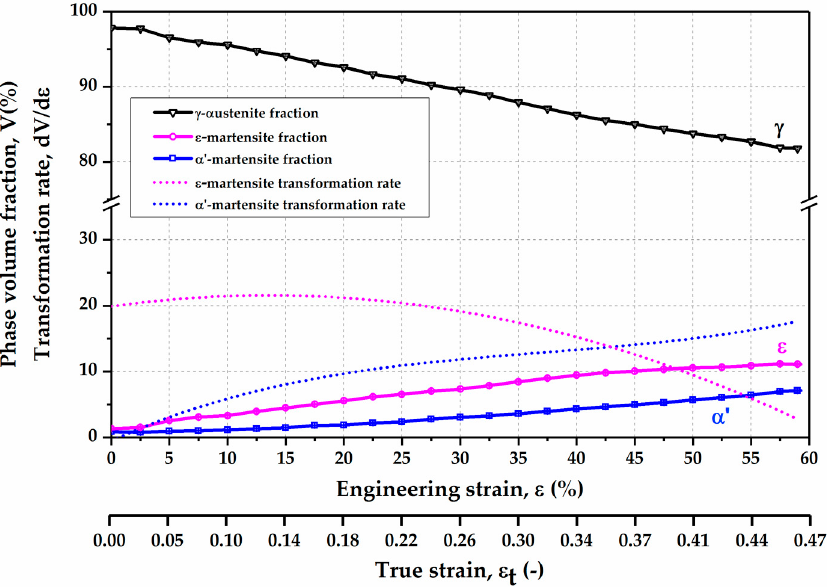
Figure 6. Phase volume fraction and corresponding phase transformation rate as a function of tensile strain in the Fe-17Mn-1.5Al-0.3C steel measured by SYXRD.